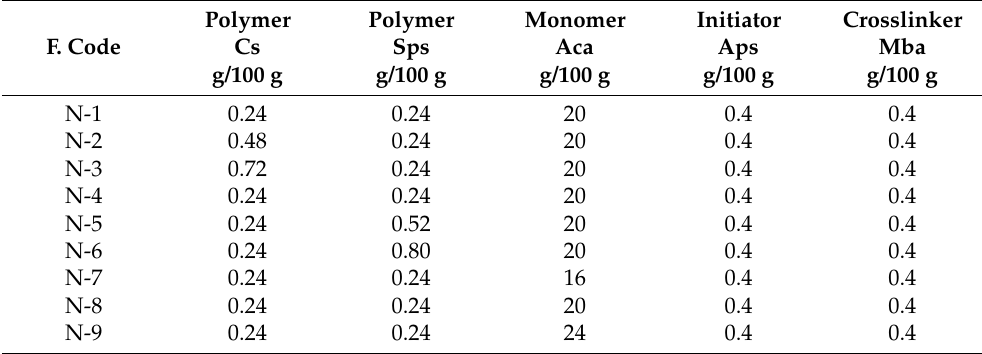
Table 4. Feed ratio scheme for formulation of Cs/SpsCpAca